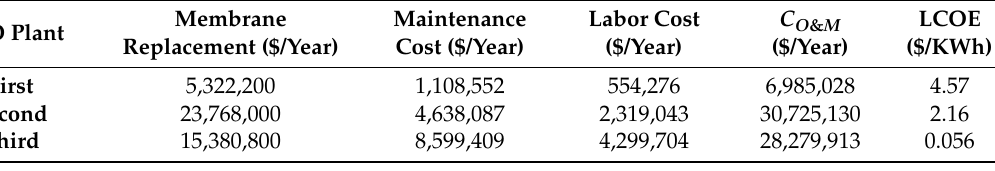
Table 8. Operation and maintenance costs and LCOE.